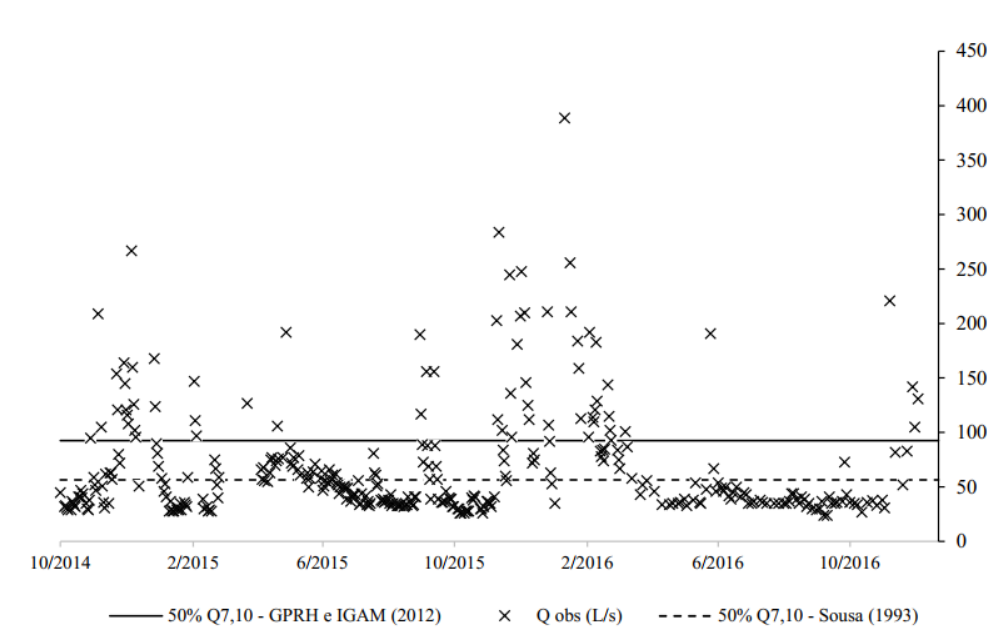
Figure 3. Observed data for the monitoring period and 50% limits of Q7,10 by GPRH & IGAM (2012) and Souza (1993)